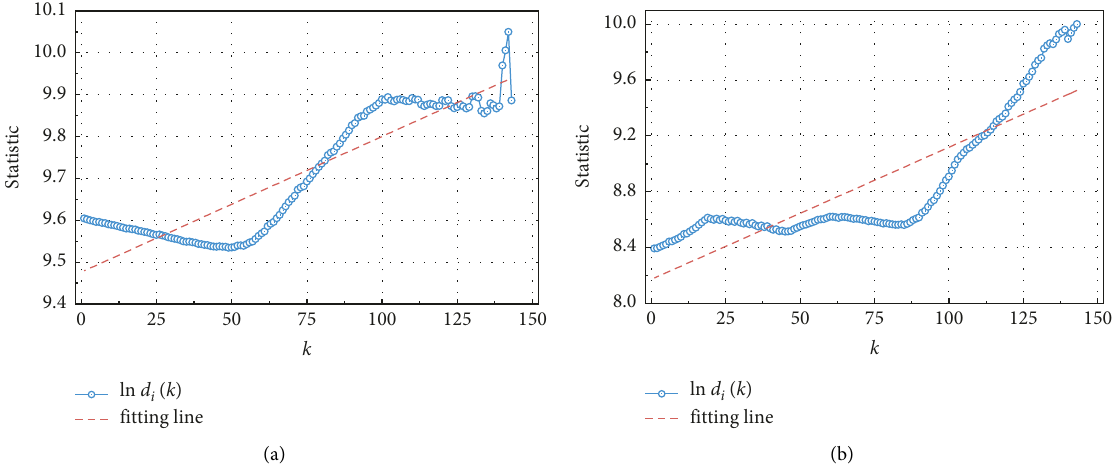
Figure 11: Evolution diagram of ln d ( k ) with k : (a) the Hefei demonstration zone ITS dataset; (b) the PeMSD8 i